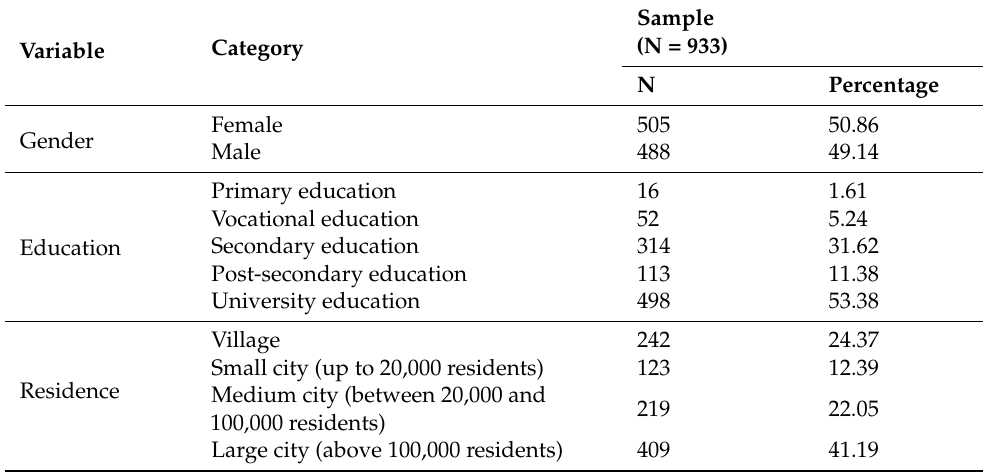
Table 2. Sample characteristics (N =